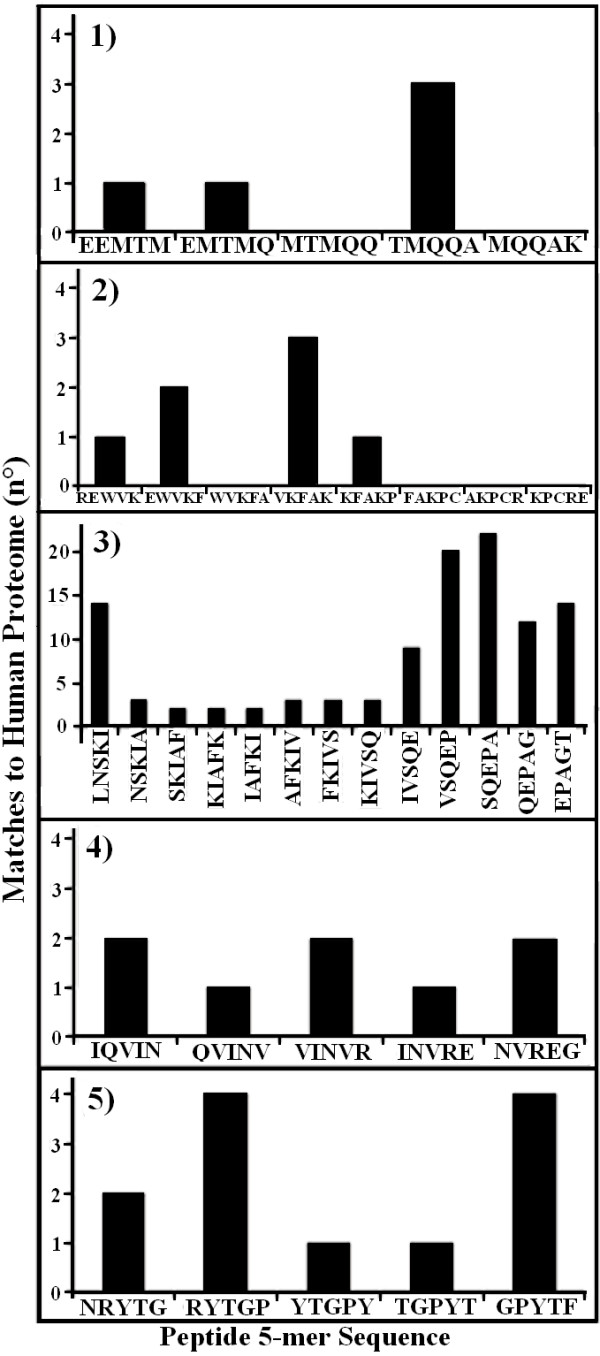
Redundancy scanning on the EC Dsg3 peptide sequences utilized in dot immunoassay analyses with human PV and PF sera. Matching analysis to the human proteome was performed using 5-mer peptide probes. Peptide: 1) Dsg336–44EEMTMQQAK; 2) Dsg349–60 REWVKFAKPCRE; 3) Dsg3190–204LNSKIAFKIVSQEPA; 4) Dsg3373–380QVINVREG; 5) Dsg3518–525NRYTGPYT.